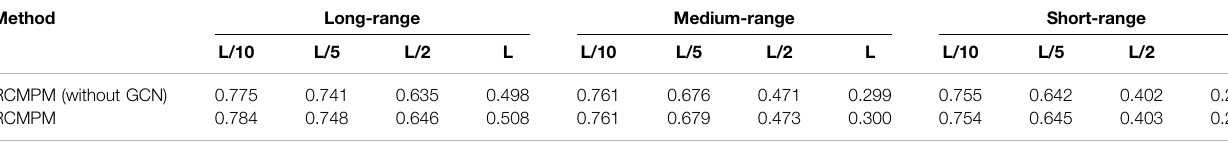
TABLE 5 | Contact map results by the comparison between our network structures. Method